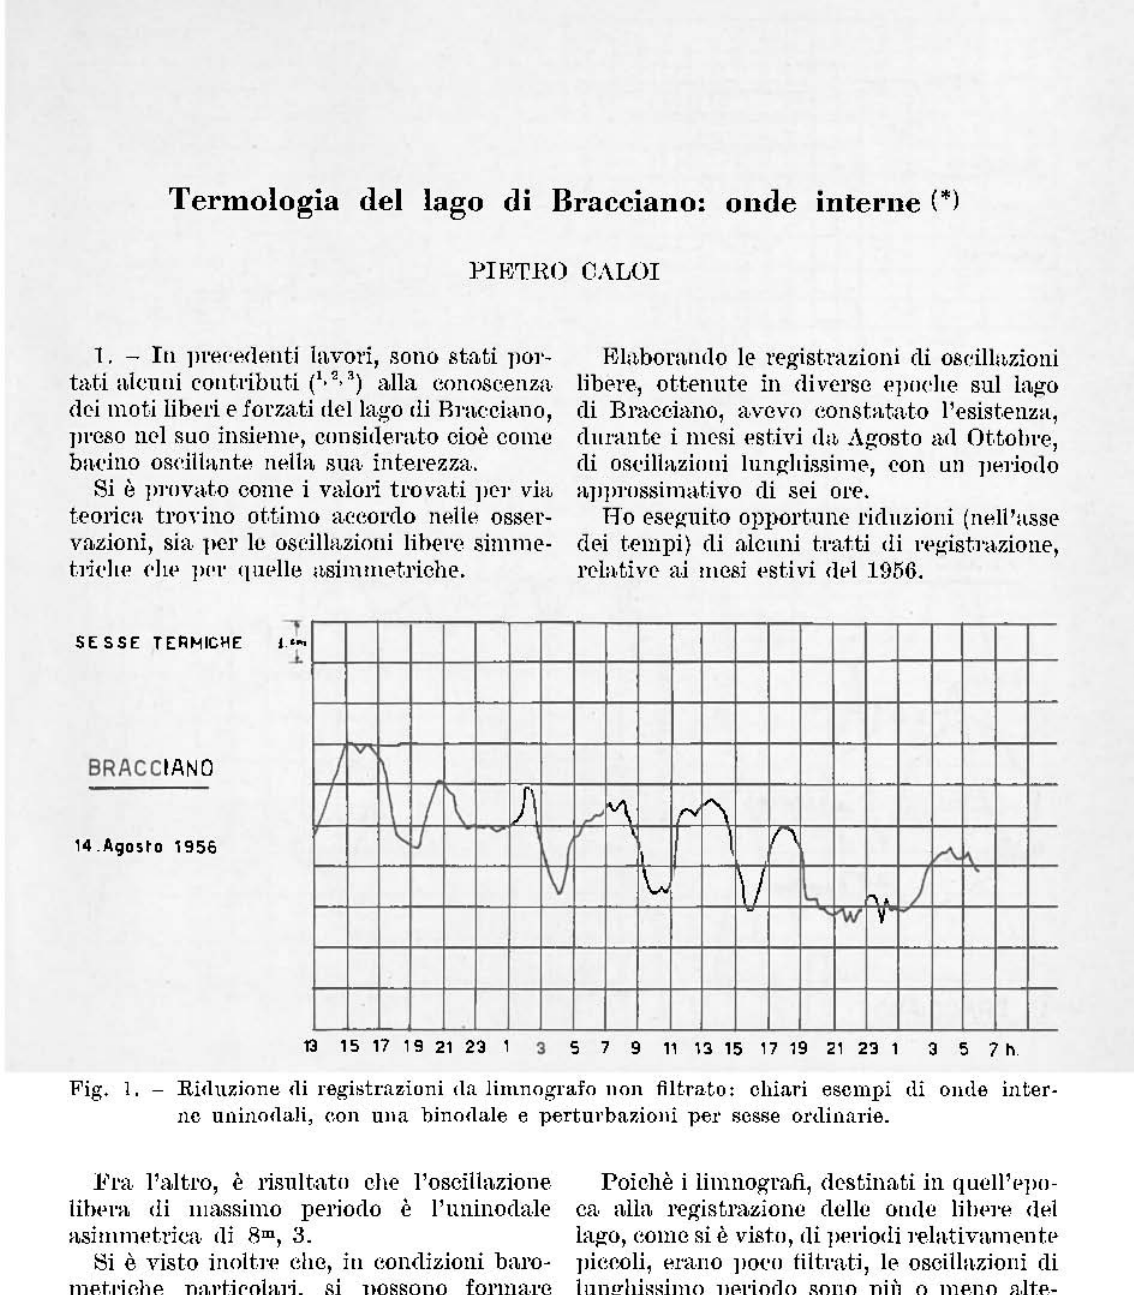
fIg. 1, appare chiaro l'insorgere di